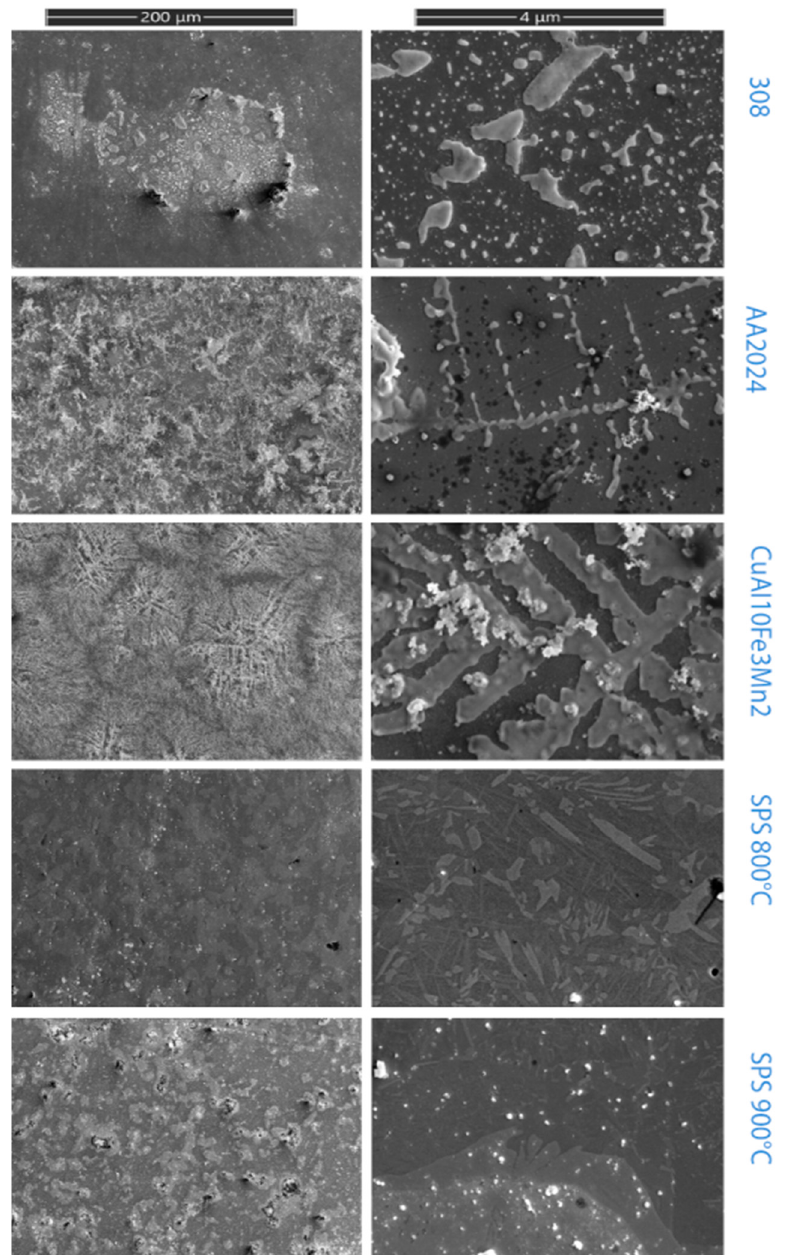
Figure 8. Samples after corrosion testing.